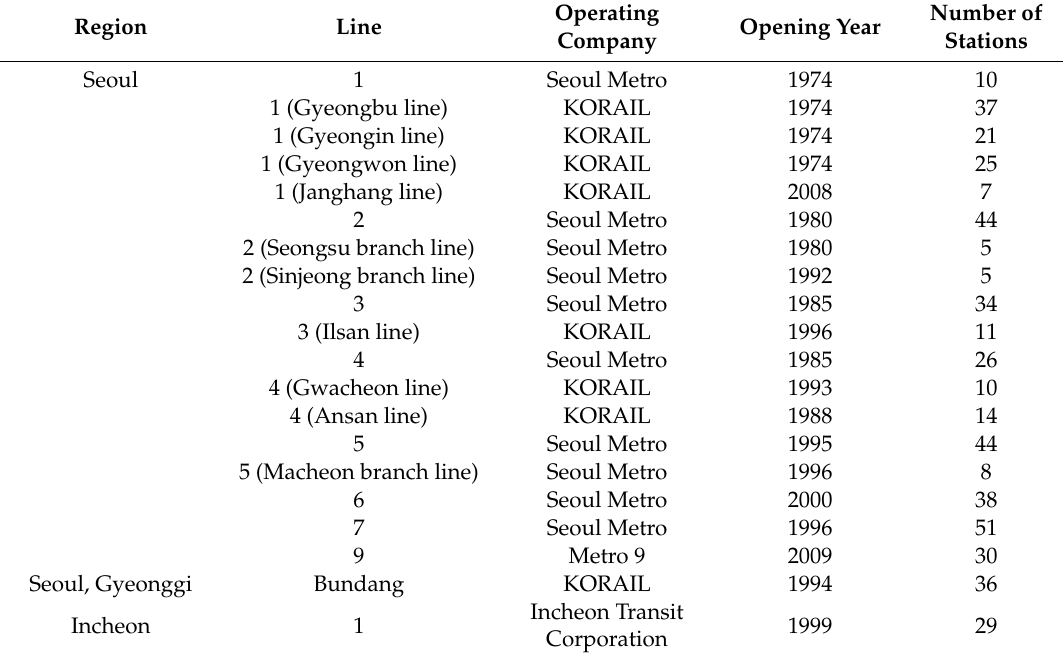
Table 1. Basic characteristics of subway lines surveyed in this